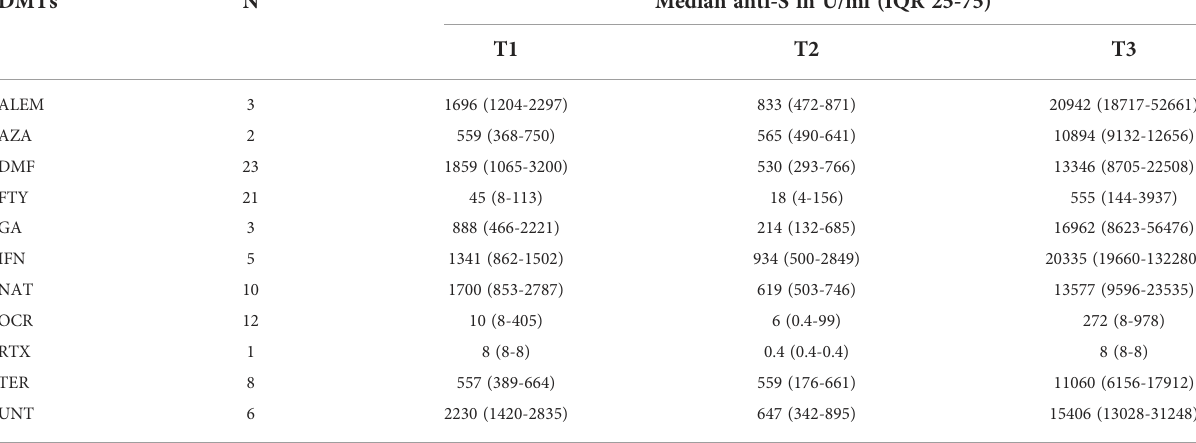
TABLE 4 Median of anti-S SARS-CoV-2 antibody levels in 94 MS patients enrolled at every time point (T1, T2 and T3) and strati fi ed by DMTs and used for longitudinal analysis. DMTs N